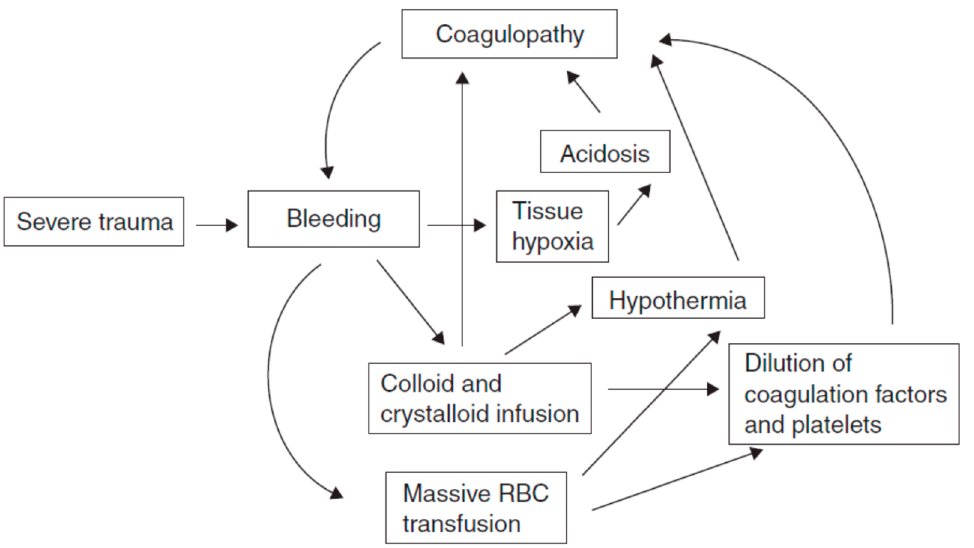
Figure 1. The interplay between metabolic acidosis, hypothermia and progressive coagulopathy in trauma.